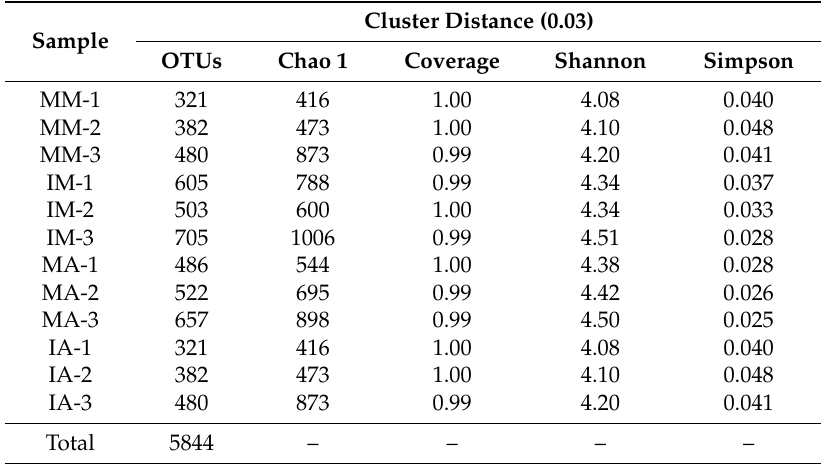
Table 2. Fungal richness and diversity of different planting